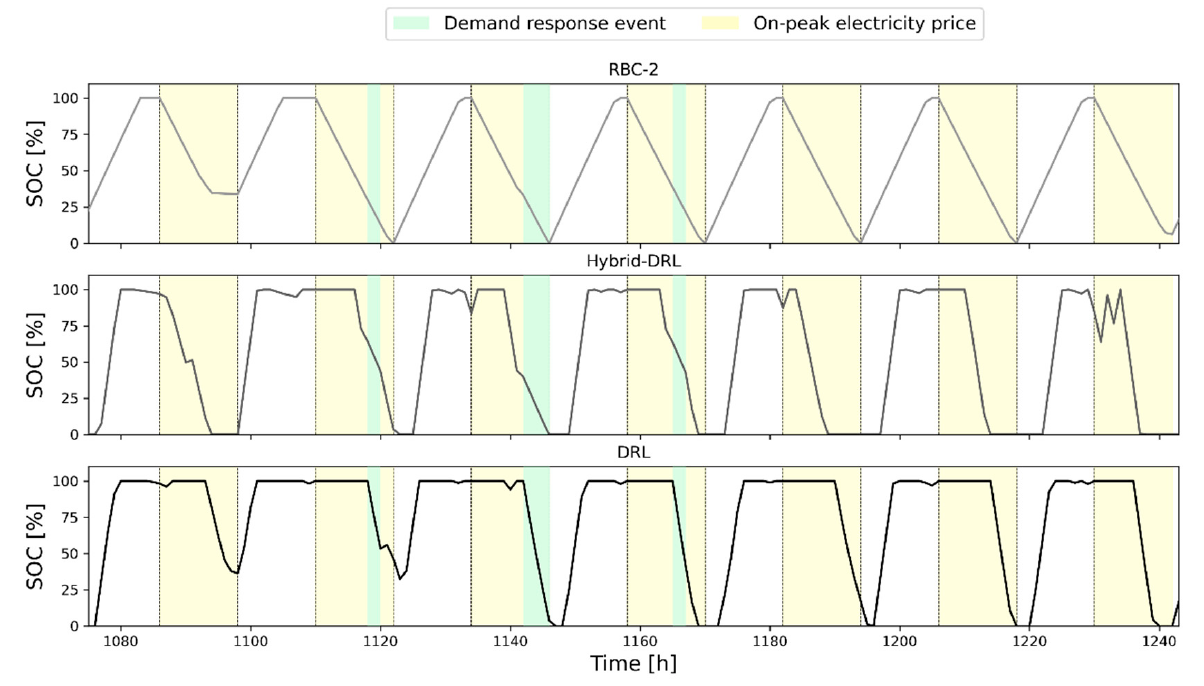
Figure 8. Evaluation of chilled water storage charging/discharging process of building 3 for RBC-2, hybrid-DRL, and DRL controllers.